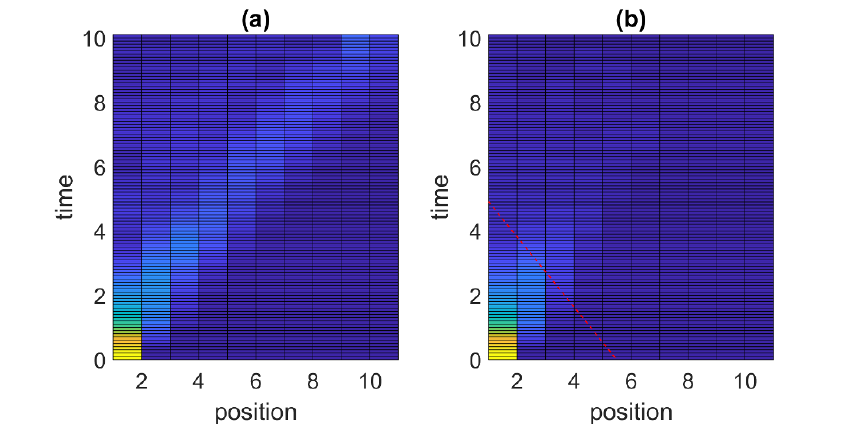
Figure 24 . Initial state dependence of the aQCI. (a) The aQCI, CI ( A : B ), of the quantum Ising model with region A being site 1 at t = 0, as a function of the position and time of the single site region B . The initial state is the ground state j G i . (b) The same quantity with the initial state U R j G i , where U R is a Haar random unitary operator acting on the right half of the system. The red dashed line is a visual guide of the \heat wavefront". The calculation is performed for the quantum Ising model with J = 1 ; ~h = [1 : 48 ; 0 ; 0 : 70], with open boundary